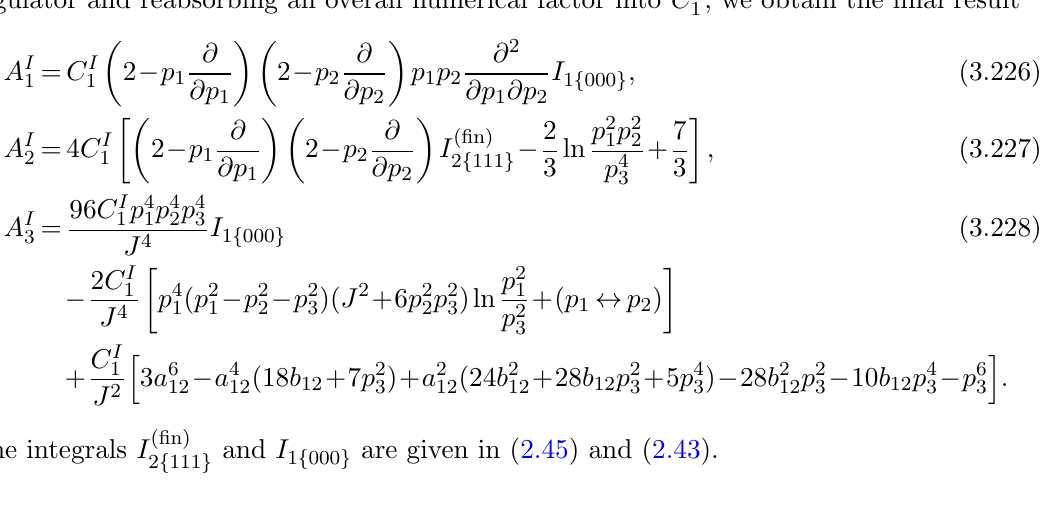
The integrals I ((cid:12)n)